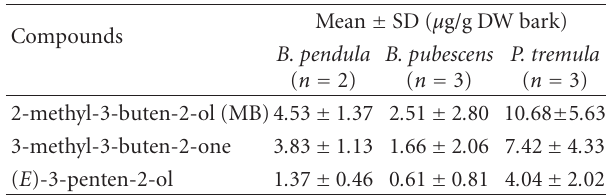
Table 2: Amounts of oxygenated hemiterpenes and ( E ) - 3-penten- 2-ol present in the bark extracts of deciduous trees, Asa, Sweden, June 11,